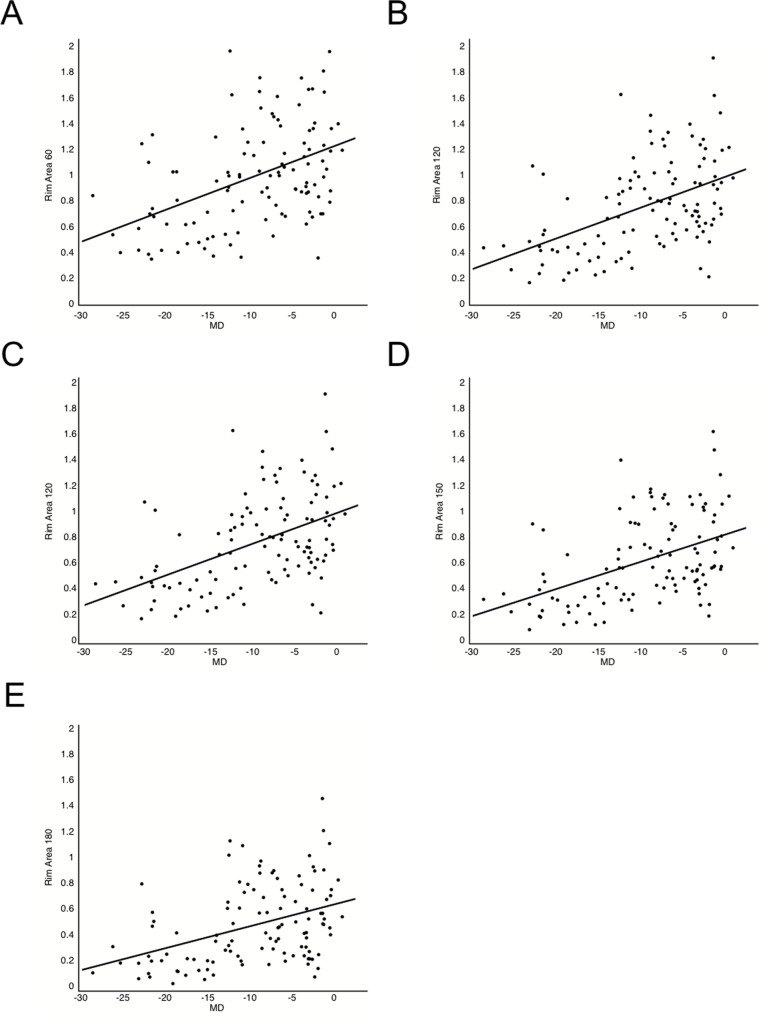
The relationship between HFA MD and rim area when the reference plane was set at different heights.(Pearson’s product/moment correlation coefficient) Scatter plot showing the relationship between rim area and HFA MD at reference plane height of 60 (A), 90 (B), 120 (C), 150 (D), and 180 (E) μm. The highest correlation between rim area and HFA MD was at 120 μm in the overall group of subjects.